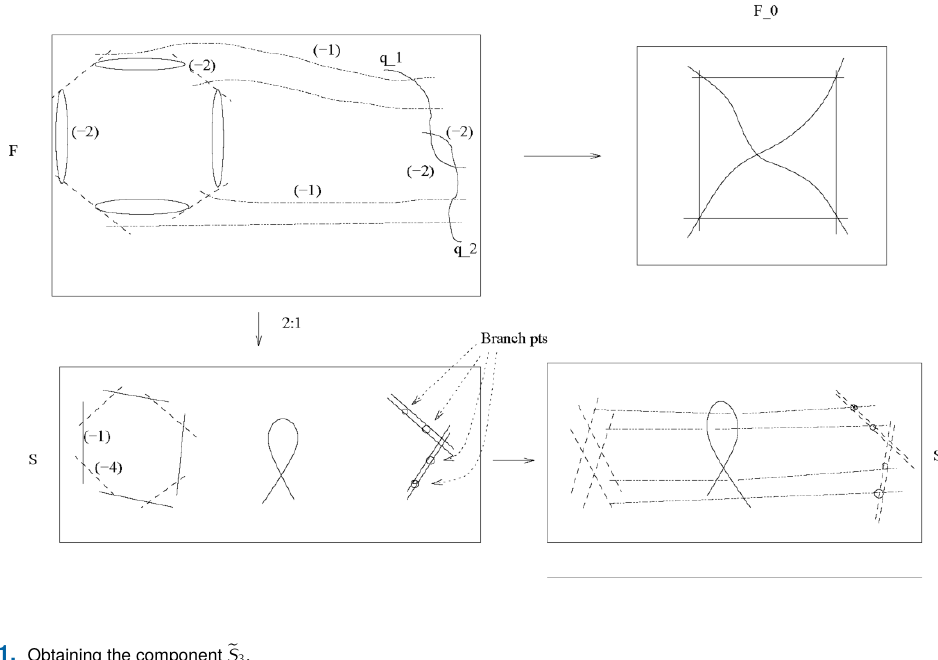
Figure 11. Obtaining the component e S